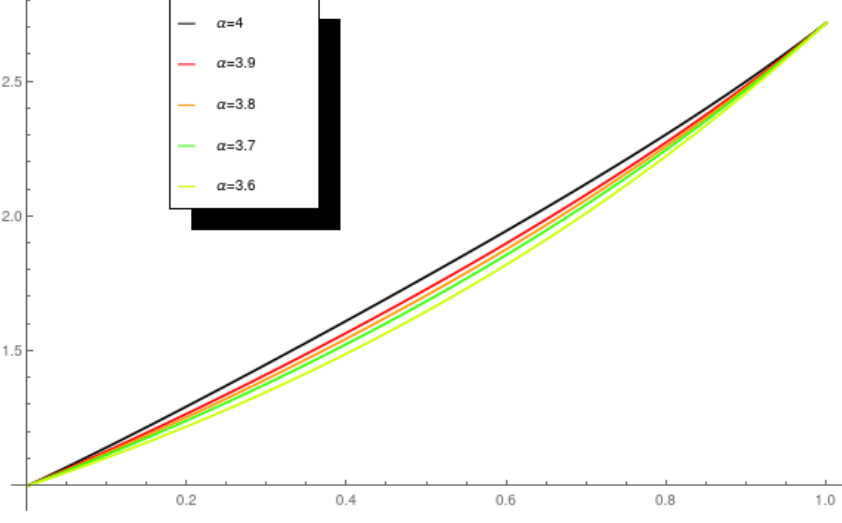
Figure 5. Approximate solutions of (26) for several values of α